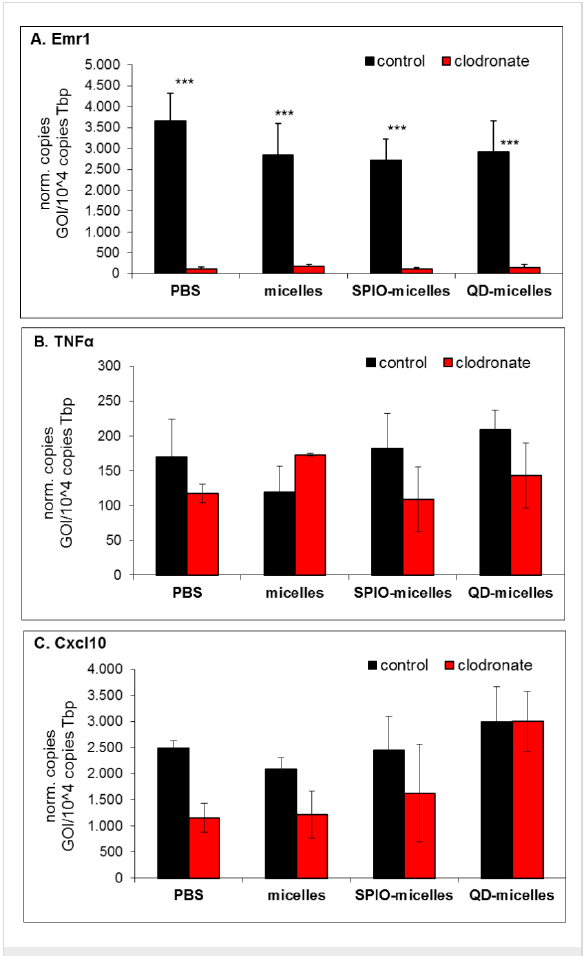
Figure 6: Impact of QDs– and SPIOs–lipid micelles on hepatic gene expression after ablation of Kupffer cells. Wild type und clodronate- treated BALB/c wild type mice were intravenously injected with PBS (control), lipid micelles, SPIOs-micelles and QDs-micelles. Livers were harvested 4 h after injection and gene expression analysis was performed for (A) Emr1, (B) TNF α and (C) Cxcl10. Mean values +/ − s.d. with n ≥ 4, *** p <